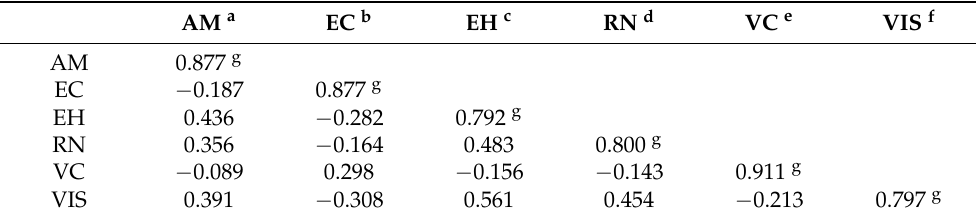
Table 3. Discriminant